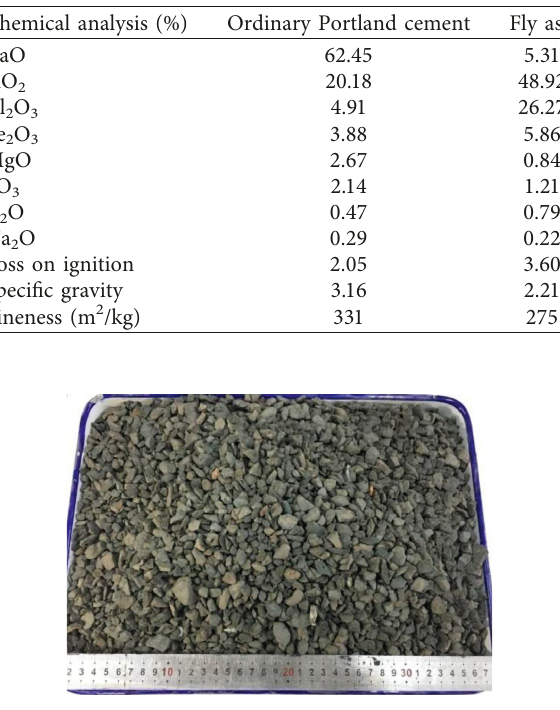
Table 1: Chemical constituents of cement and fly ash.